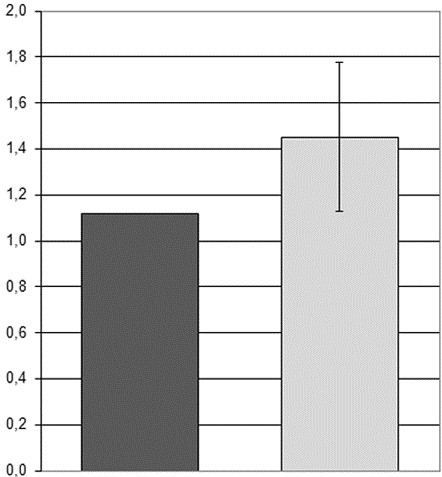
Relative expression of RUNX1 in the BM of patient 2. The dark grey bar refer to the patient and the light grey bar to controls’ average values, UBC was used as control